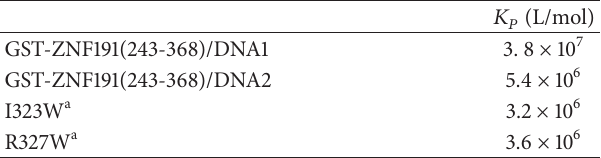
Table 2: The value of 𝐾 𝑃 of ZNF191 (243-368) and